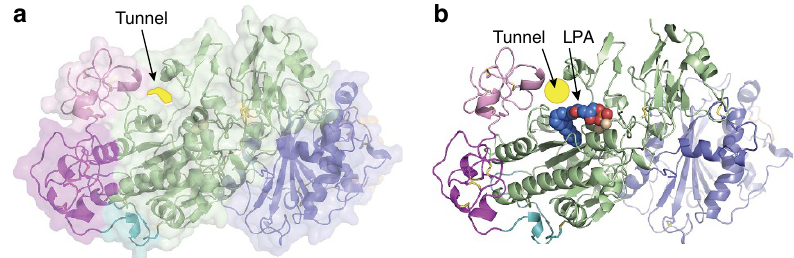
Figure 1 | The tunnel of ATX. ( a ) A cartoon representation of the domain structure of ATX combined with a transparent surface highlighting the position of tunnel; the SMB domains are coloured in pink and magenta, the PDE domain in green, the NUC domain in blue, the lasso loop wrapping around the NUC domain in orange and the short loop connecting the SMB domains to the PDE domain in cyan; the zinc ions are shown as spheres; a yellow background highlights the tunnel site, ( b ) the same cartoon model, with bound LPA18:1 (PDB:3NKP) and a yellow circle designating the tunnel site. All structural images were generated using PyMOL (http://www.pymol.org) or CCP4mg 48